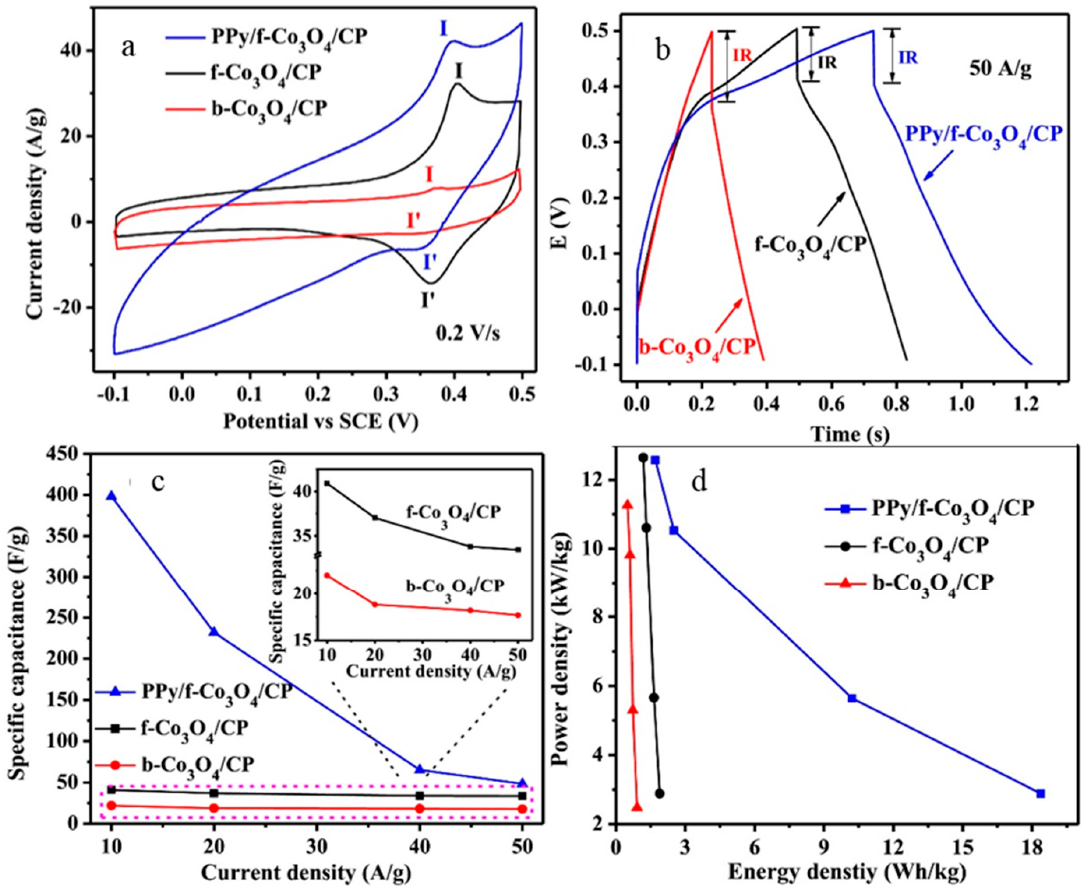
Figure 17. ( a ) CV comparison at a scan rate of 0.2 V s − 1 , ( b ) charge-discharge curves at 50 A g − 1 , ( c ) current density dependent specific capacitance in potential range from − 0.1 to 0.5 V and ( d ) Ragone plots of f-Co 3 O 4 /CP, b-Co 3 O 4 /CP, and PPy/f-Co 3 O 4 /CP composite electrodes in 2.0 M KOH aqueous solution [145] .